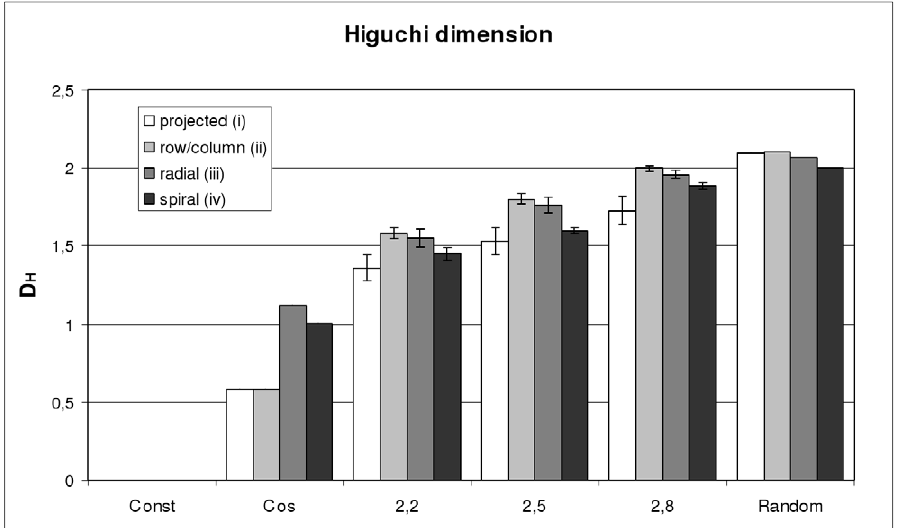
Figure 3. Higuchi dimensions of fractal and non-fractal images. Higuchi dimensions for an image with a constant gray value, an image with a cosine shaped gray value course in the x-direction, three images with predefined fractal dimensions (D=2.2, 2.5, 2.8) and an image with random gray values. The legend depicts the distinct 2D to 1D methods (i)–(iv). (i) projection and averaging the values for the x- and y-direction. (ii) examining every row and column and calculations of averages. (iii) 180 radial lines through the centre of the image and calculations of averages and (iv) spirals through the image and calculations of averages.